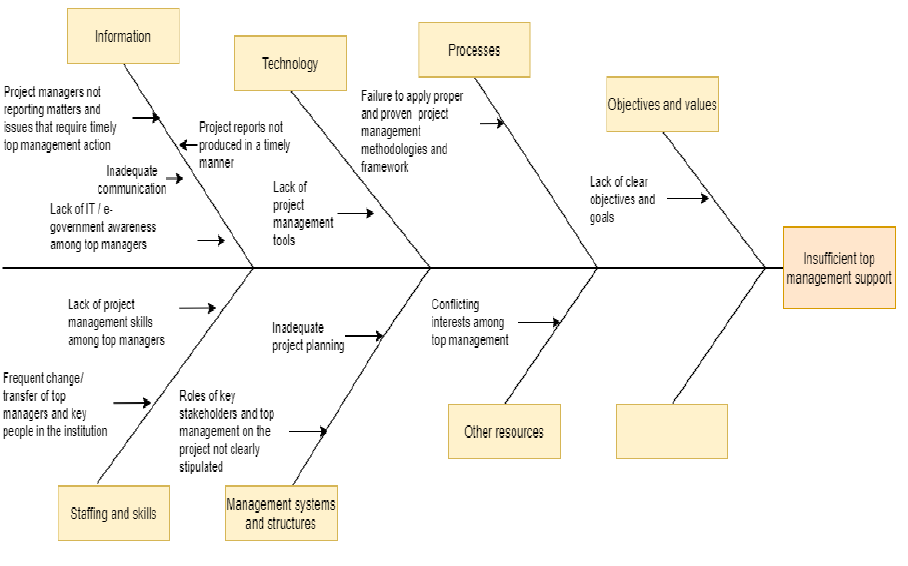
Figure 7: Insufficient top management